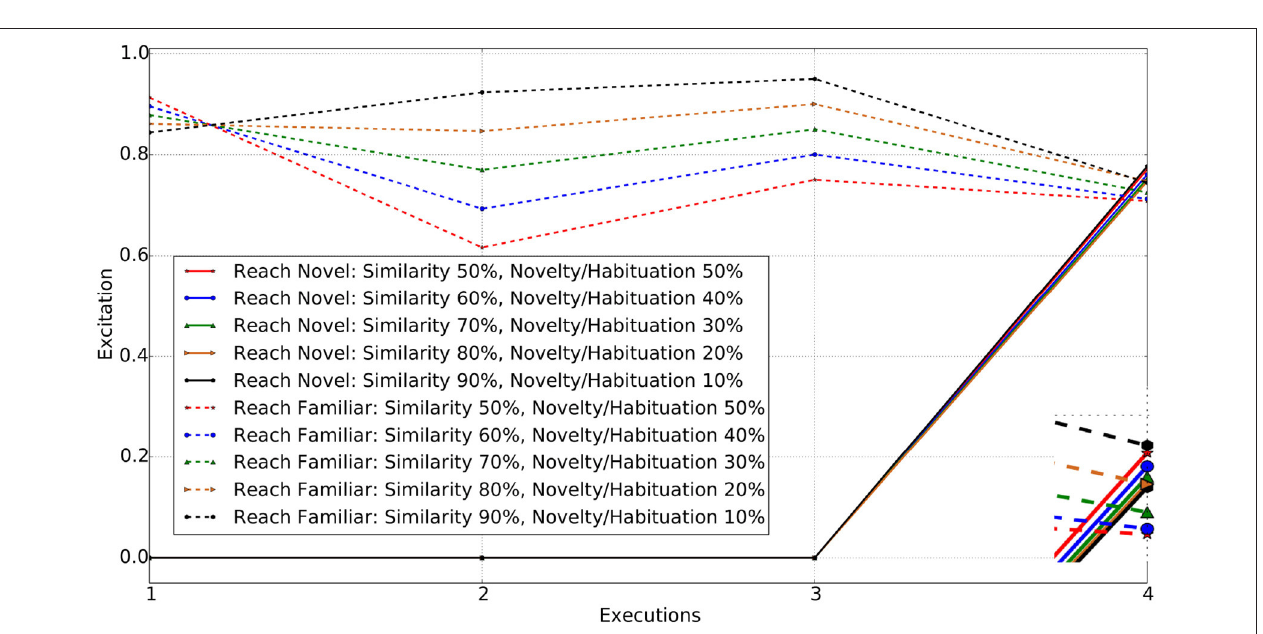
to provide the same outcomes in order to ensure they both provide the same object excitation based on similarity, novelty and habituation. Thus, the excited schema (or excited action) depends on the schema excitation as described in Equation 7 and its weight ( ω 4 ). The agent’s observed behaviors for different values of the ω 3 and ω 4 are shown in Figure 8 .